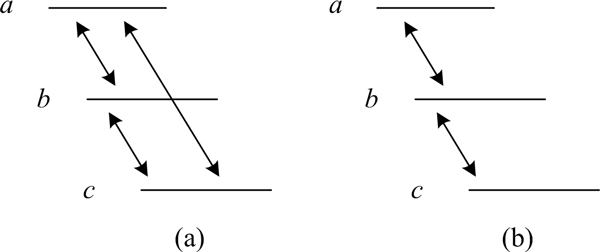
From overlap graph to a string graph. (a) an overlap graph, in which all the overlaps are recorded. (b) the string graph, transitive overlap (a, c) is removed.